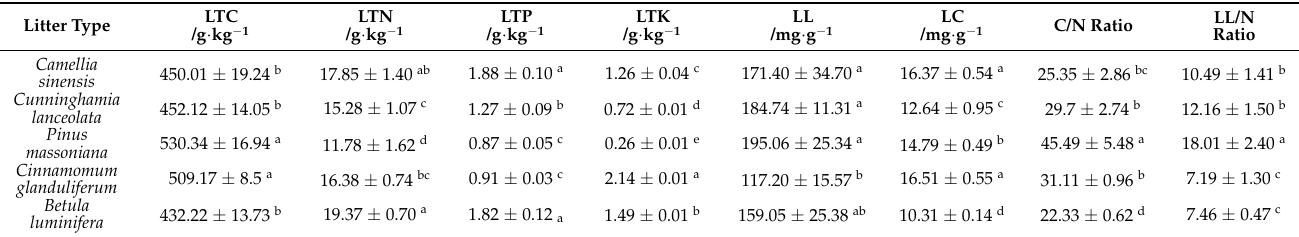
Figure 1. Experimental study area. Table 1. Basic nutrient properties of the tested